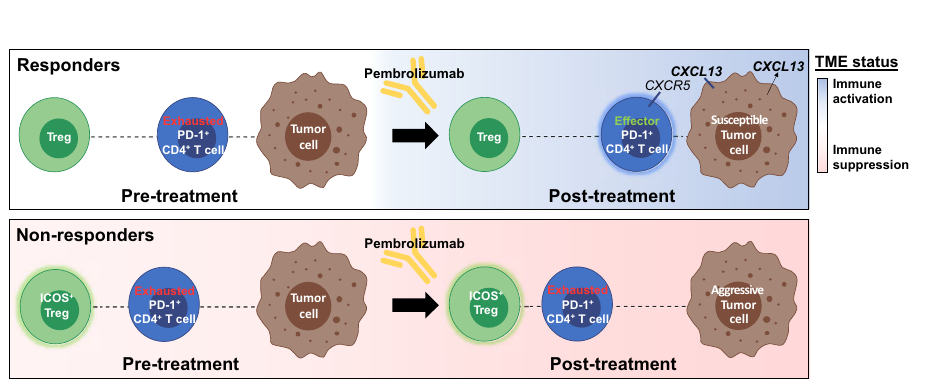
Fig. 5 CXCL13 is a key driver of pembrolizumab response in CTCL. a Seven genes from bulk RNAseq data predictive of the SpatialScore . b Normalized bulk CXCL13 gene expression per tissue microarray spot. Boxes, median ± upper and lower quartiles; whiskers, 1.5x IQR. P values calculated with a linear mixed- effect model with Bonferroni ’ s corrections for multiple comparisons. c CXCL13 protein expression by IHC per tissue microarray spot (mean, red bar). P values calculated with a linear mixed-effect model with Bonferroni ’ s corrections for multiple comparisons. d Representative CXCL13 IHC images from responder patient 9 (left panels) and nonresponder patient 14 (right panels). Scale bars, 20 µ m. e – f CXCL13 expression in single-cell transcriptomes from CTCL skin tumors (Gaydosik et al.) 62 . e Normalized expression of CXCL13 in single cells; excluded cells with CXCL13 log1p normalized read counts < 0.5. Boxes, median ± upper and lower quartiles; whiskers, 1.5x IQR. f Proportion of CXCL13-expressing cells per cell type. g CIBERSORTx work fl ow schematic. A CSx deconvolution signature matrix was generated from single-cell transcriptomes (Gaydosik et al.) 62 (left) and applied to CTCL bulk transcriptomes obtained with laser-capture microdissection (LCM) and Smart-3Seq (right) to enumerate cell type fractions and resolve gene expression pro fi les. h Heatmap correlation of CSx-resolved and CODEX-identi fi ed cell type frequencies; Spearman coef fi cients are on the diagonal. i – j Differential expression of CSx-resolved tumor cell genes in responders ( j ) and nonresponders ( k ) pre- and post-treatment. P values calculated with a linear mixed-effect model with Benjamini-Hochberg correction (signi fi cantly different genes ( p < 0.1), red; CXCL13 highlighted yellow). k Vectra mIHC image (top left), corresponding tumor cell depiction (top right), corresponding CXCL13 IHC image (bottom left), and corresponding overlay image of CXCL13 staining and tumor cells (bottom right) in responder patient 9 post-treatment. Scale bars, 20 µ m. l Normalized CSx-resolved CXCL13 expression in tumor cells per tissue microarray spot. Boxes, median ± upper and lower quartiles; whiskers, 1.5x IQR. P values calculated with a linear mixed-effect model with Bonferroni ’ s corrections for multiple comparisons. m – n Pre- to post-treatment changes in normalized CXCL13 gene expression from CSx-resolved tumor genes per patient in responders ( m ) and nonresponders ( n ). Boxes, median ± upper and lower quartiles; whiskers, 1.5x IQR. P values calculated by two-sided Wilcoxon ’ s signed-rank tests. o Correlation of CSx-resolved tumor cell CXCL13 expression and bulk CXCR5 expression per tissue microarray spot. Data evaluated with two-sided Spearman test. Source data are provided as a Source Data fi le.